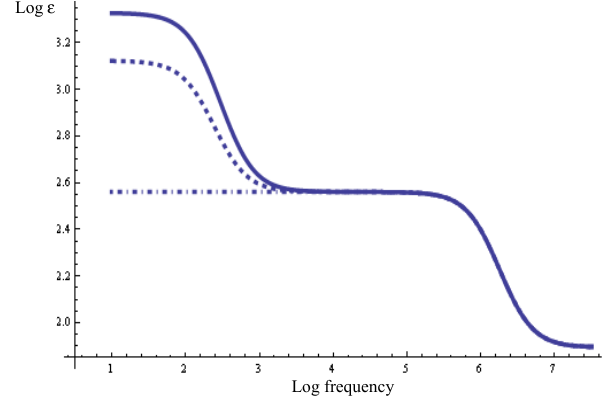
Fig. 1A: Permittivity spectra: Δϕ 0 = -150 mV (solid), Δϕ 0 = -75 mV (dashed), Δϕ 0 ~ 0 V (dot-dashed line)